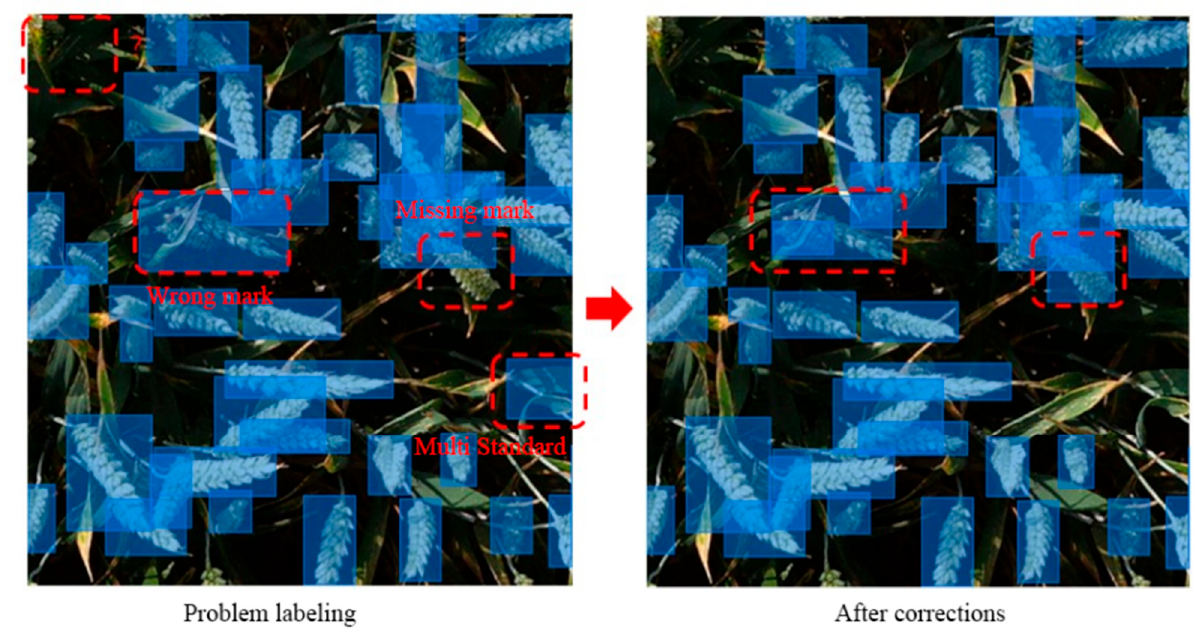
Figure 3. Part of the datasets corrected.